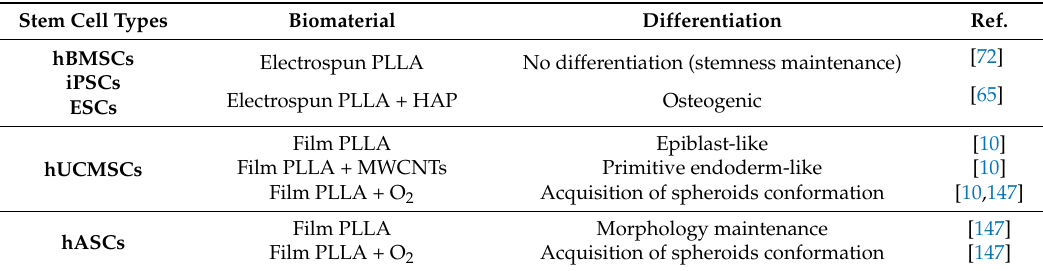
Table 2. Biological effects of poly- L -lactide (PLLA) polymer in different form (electrospun fibers and film), in combination with different nanofillers [hydroxyapatite (HAP) or multiwalled carbon nanotubes (MWCNTs)] or after oxygen (O 2 ) modification in different stem cell